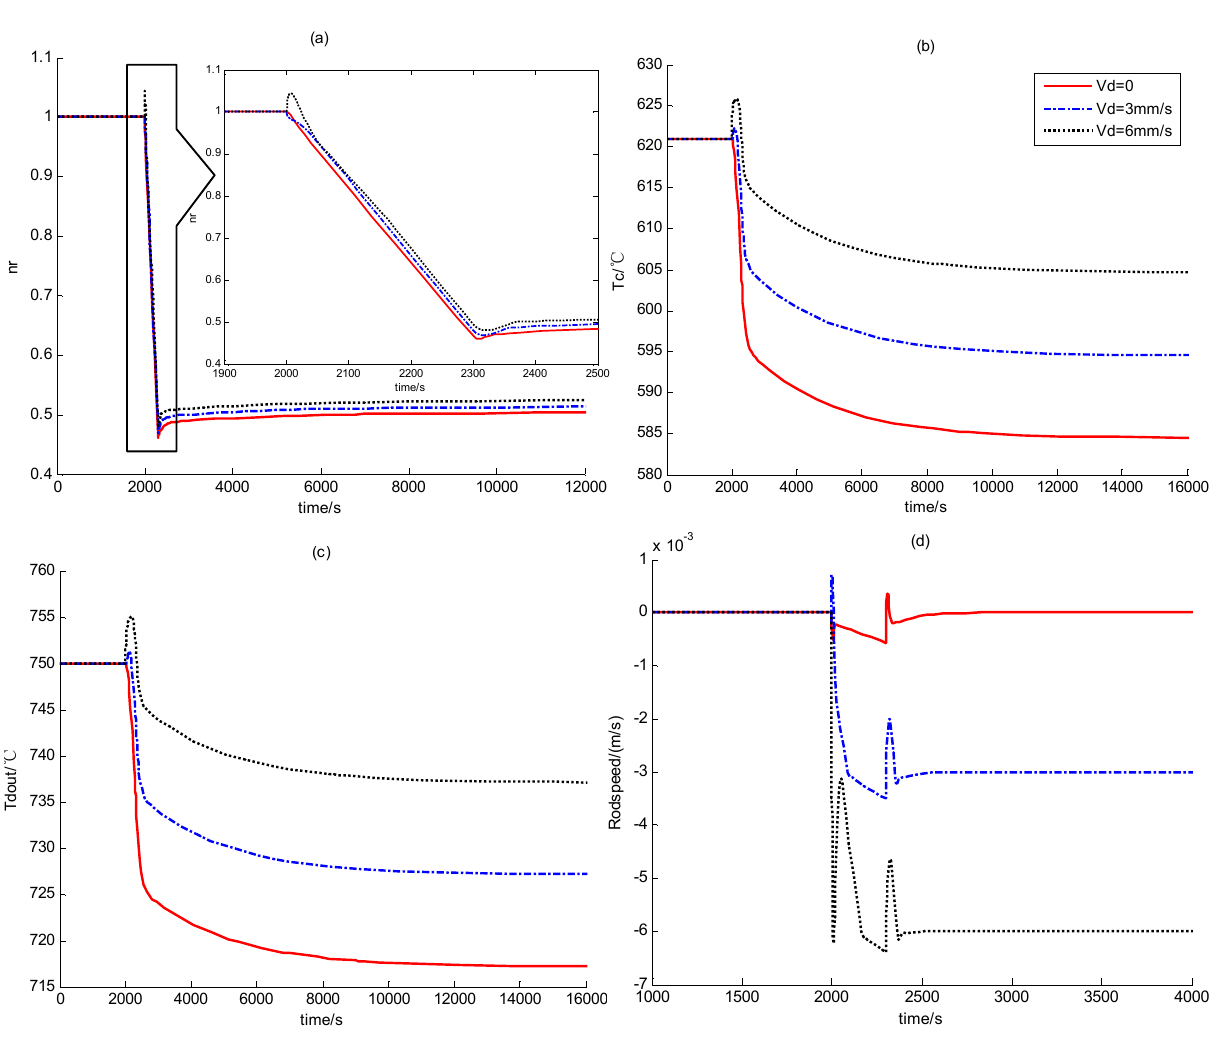
Figure 4. Power drop controlled by proportional PLC. ( a ) Relative nuclear power-level; ( b ) Average temperature of fuel elements; ( c ) Outlet helium temperature of the reactor; ( d ) Control rod speed